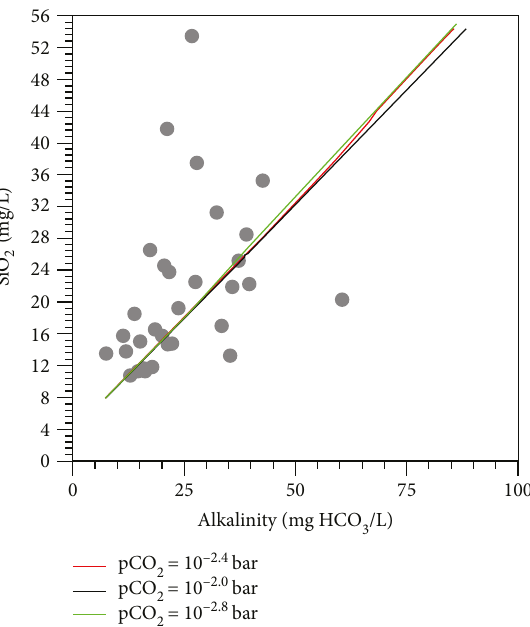
Figure 9: Plots of SiO vs. alkalinity showing the analytical data 2 from groundwaters interacting with granulitic rocks of the lower crust as well as the results of reaction path modeling for granulite dissolution under di ff erent pCO (see 2 di ff erent, constant pCO values (10 -2.0 , 10 -2.4 , and 10 -2.8 bar) 2 and at constant temperature of 11.8 ° C.